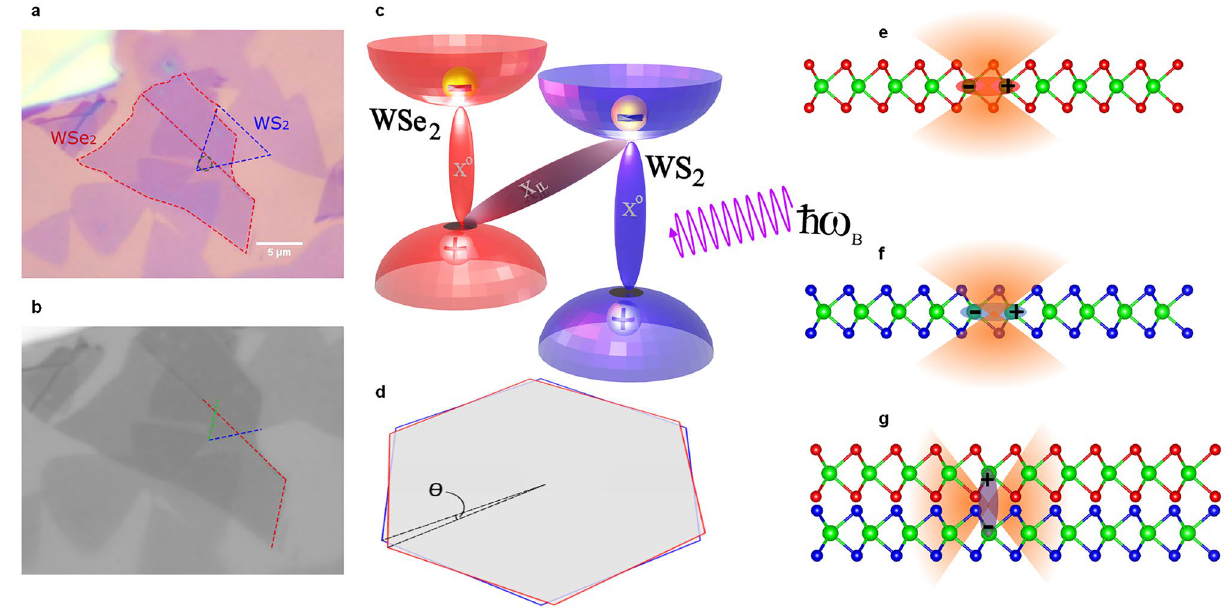
Figure 1. Representation of different excitonic features (transitions) and their corresponding radiative emission patterns of WS 2 /WSe 2 vdW heterostructure (HS). ( a , b ) Optical micrograph for WS 2 /WSe 2 heterobilayer (HBL) on SiO 2 /Si 2 substrate (300 nm thermal oxide layer) taken under 100× objective. ( a ) White light color readout. The relevant monolayer (ML) area for WSe 2 is indicated by the red-dotted frame lines, for WS 2 by the blue- dotted ones. The dotted circle represents the HBL spot under investigation. ( b ) Intensity profile of the green channel. The red-line marked edges of the top flake and blue/green-lined edges of the CVD (bottom) flake of the HBL region indicate the twist angle θ, here estimated visually to be 56°. ( c ) Schematic drawing of type-II band alignment of the HS. The A-exciton (X 0 ) transitions are sketched in red and blue colors for WSe 2 and WS 2 , respectively. Furthermore, the charge-transfer interlayer exciton (ILX, X IL ) is indicated as a gray colored transition. ( d ) A sketch of two twisted lattice Brillouin zones in k -space is shown, hinting at the possible phase- space mismatch at the corners (representing K and K’ valleys of TMDCs) with increasing angle of θ. ( e – g ) In WS 2 and WSe 2 MLs, an in-plane dipole orientation for intralayer excitons and their respective out-of-plane radiative emission patterns can be seen. For interlayer excitons, which are formed across the interface of two different HS layers, an out-of-plane dipole orientation and the in-plane radiation pattern is